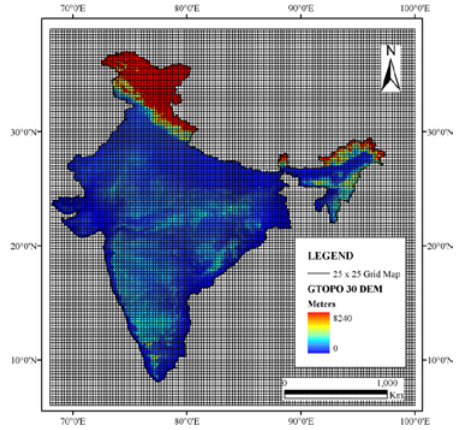
Figure 3. GTopo 30 DEM map of India showing its